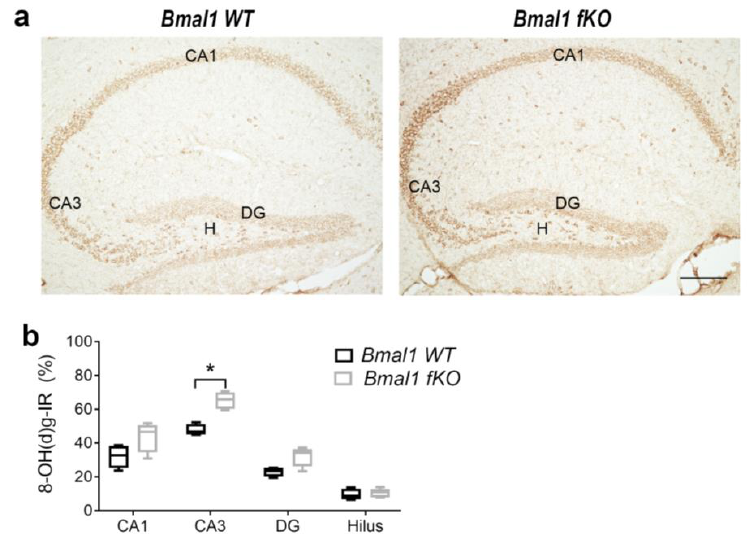
Figure 1. Oxidative stress in the hippocampus of mice with conditional deletion of Bmal1 from forebrain excitatory neurons ( Bmal1 fKO ) mice. ( a ) Representative photomicrograph of the oxidative stress marker 8-hydroxydeoxyguanosine immunoreaction (8-OH(d)g-IR) in the hippocampus of wildtype mice ( Bmal1 WT ) and Bmal1 fKO . Scale bar = 200 µm. ( b ) Quantitative analysis of 8-OH(d)g-IR in hippocampal subregions of Bmal1 WT and Bmal1 fKO mice. * p < 0.05. DG, dentate gyrus, H, hilus, CA, cornu ammonis.